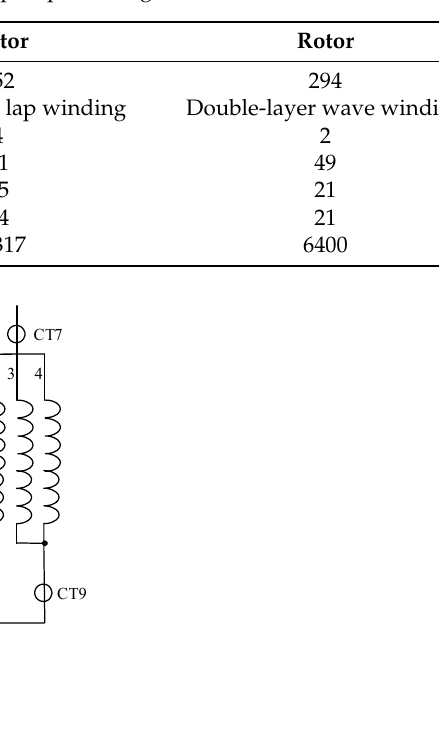
Table 1. The basic parameters of a variable-speed pumped storage unit.